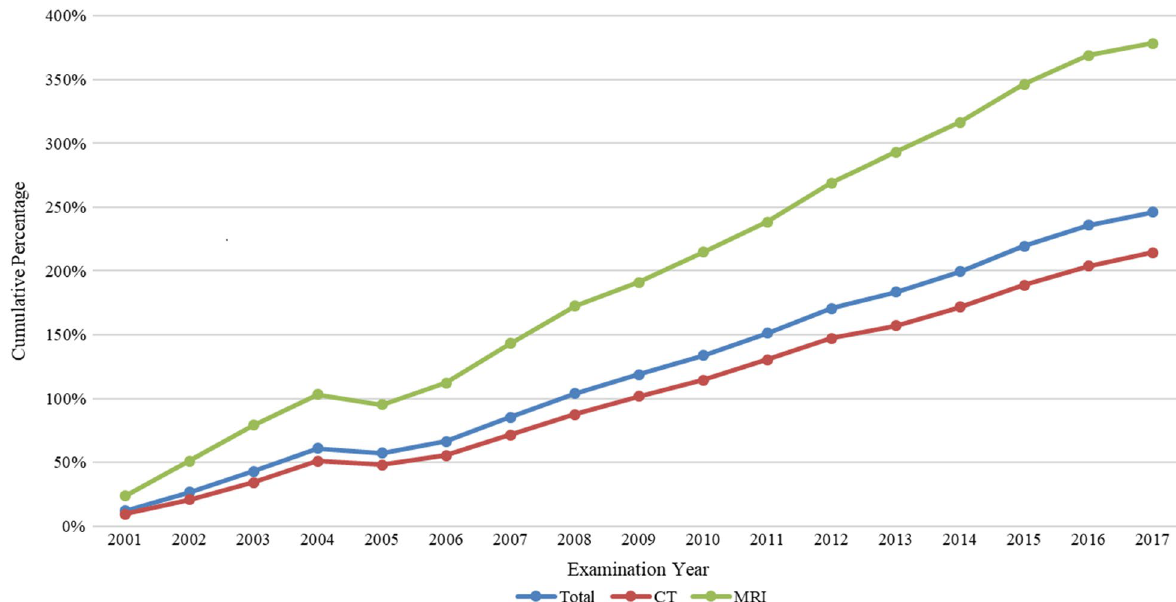
Fig. 1 The cumulative percentage of medical imaging utilization in Taiwan from 2000 to 2017